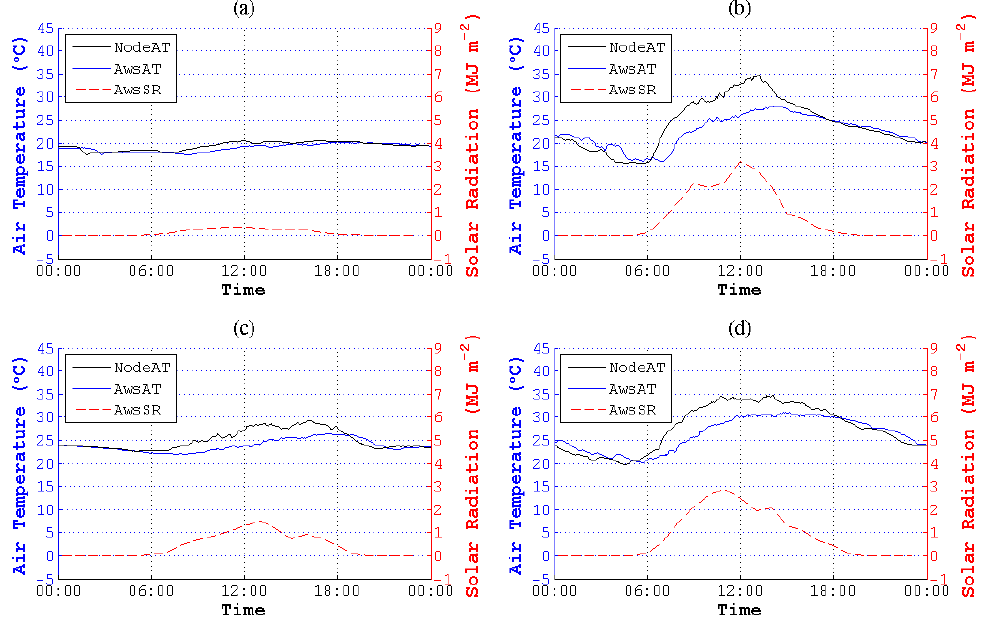
Figure 1. Air temperature (AT) values collected by the sensing node (NodeAT), AT collected by the automatic weather station (AWS) (AwsAT) and AwsSR (SR, solar radiation) sensed directly by different kinds of sensors on four days in May. ( a ) Thundershowers with early/moderate rain late on 10 May 2014; ( b ) cloudy on 13 May 2014; ( c ) showers on 25 May 2014; ( d ) clouds that are early/clearing late on 27 May 2014. The SRs in ( a , c ) were